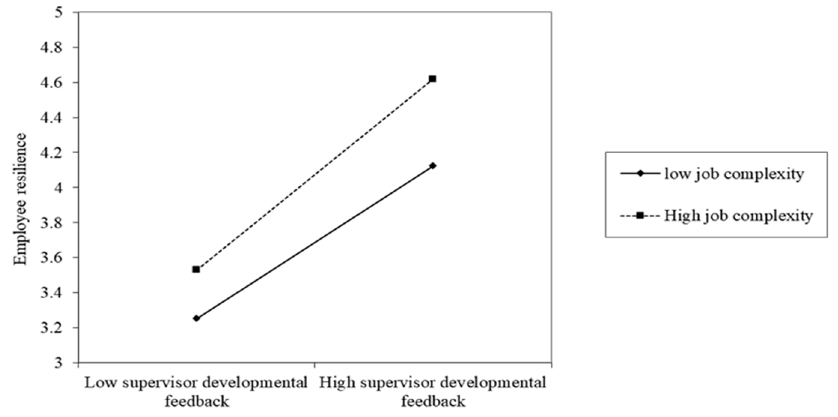
Figure 2. Moderating effect.